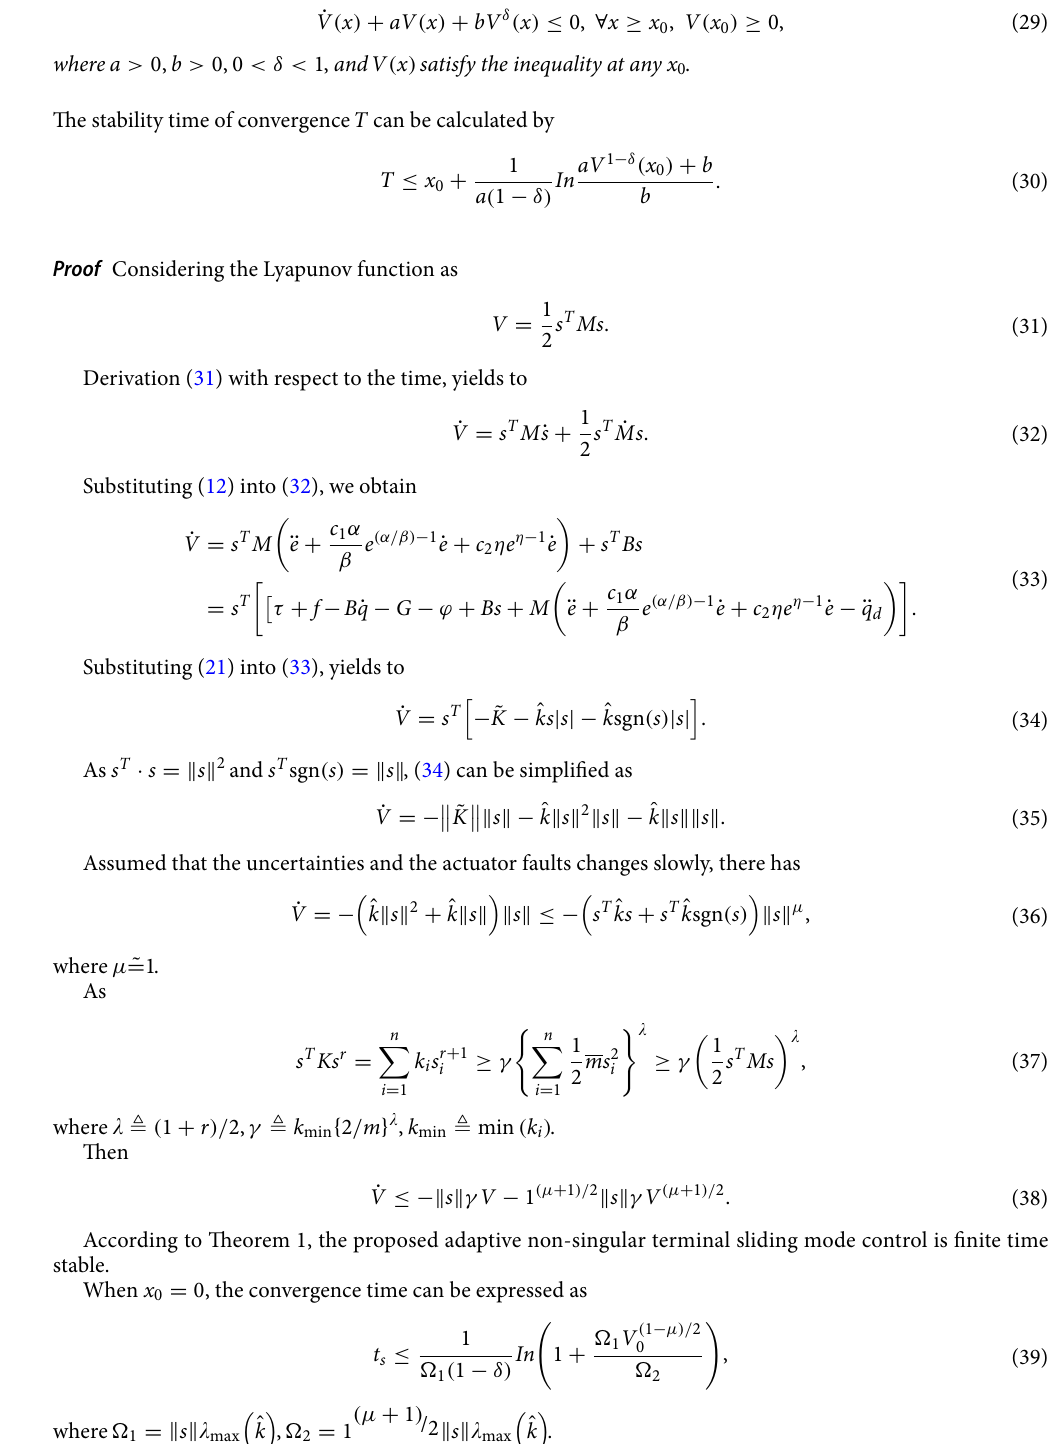
Contour error compensation with cross coupling